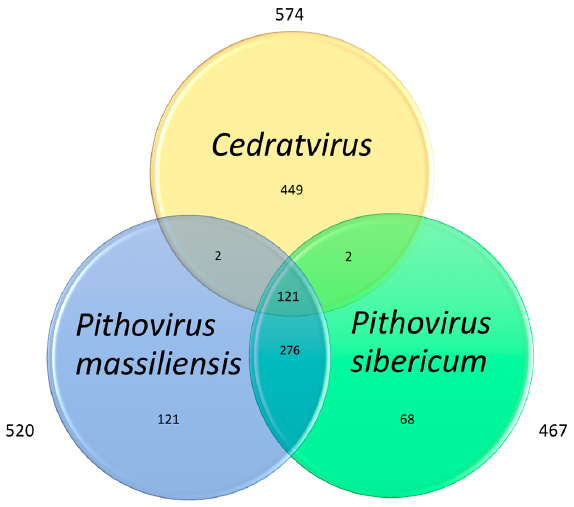
Figure 2. Co ‐ orthologous genes representing the current putative Pithoviridae family.